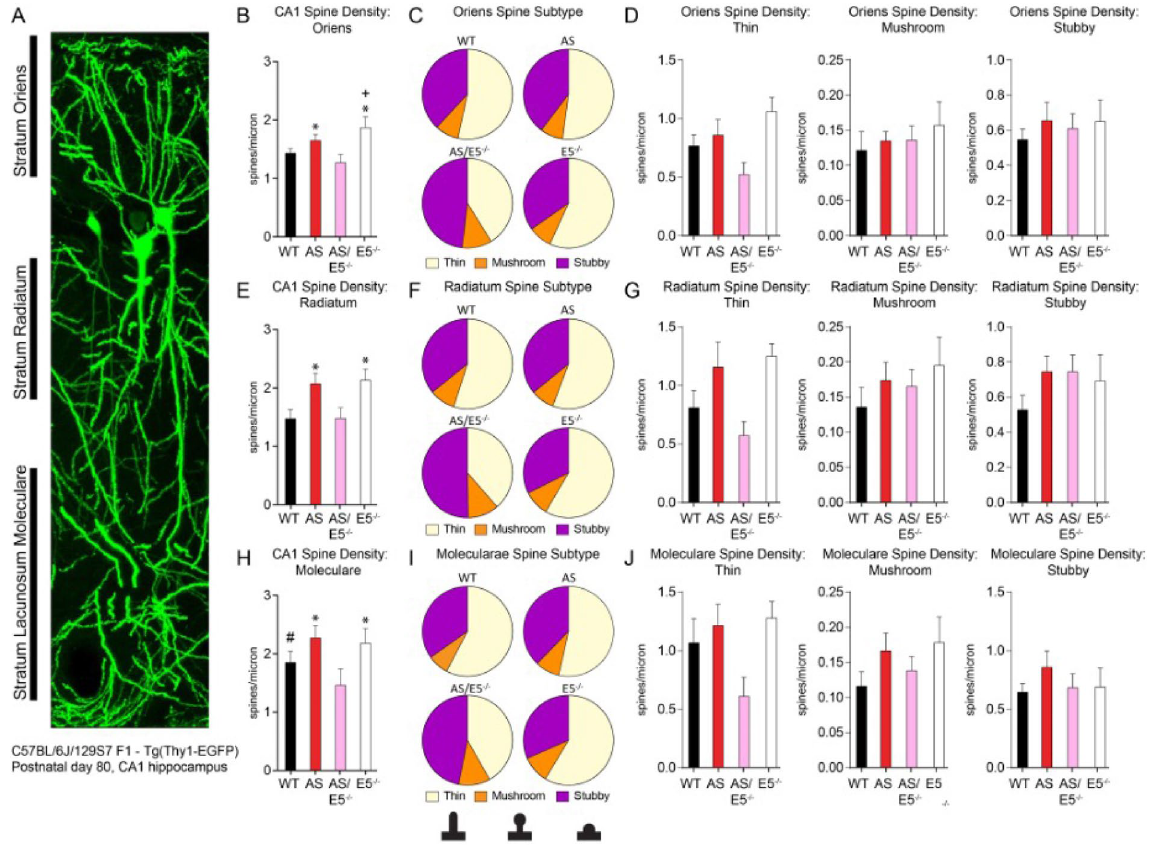
Figure 3. UBE3A expression in CA1 and location of spine analysis in CA1 GFP-positive neurons, related to Fig. 3. ( A ) Example CA1 GFP-positive neurons with the regions of interest labeled (stratum oriens, stratum radiatum, and stratum moleculare). Scale bar is 10 μm. ( B ) Oriens spine density in CA1. ( C ) Proportion of spine subtypes within WT, AS, AS/E5 −/− , and E5 −/− oriens dendrites of CA1 neurons. ( D ) Spine density in the stratum oriens of CA1 neurons for thin, mushroom, and stubby morphologies. ( E ) Radiatum spine density in CA1. ( F ) Proportion of spine subtypes within WT, AS, AS/E5 −/− , and E5 −/− radiatum dendrites of CA1 neurons. ( G ) Spine density in the stratum radiatum of CA1 neurons for thin, mushroom, and stubby morphologies. ( H ) Moleculare spine density in CA1. ( I ) Proportion of spine subtypes within WT, AS, AS/E5 −/− , and E5 −/− moleculare dendrites of CA1 neurons. ( J ) Spine density in the stratum lacunosum moleculare of CA1 neurons for thin, mushroom, and stubby morphologies. One-way ANOVA, post-hoc Tukey’s multiple comparisons test for panels B, E, and H. Two-way ANOVA, post-hoc Sidak’s multiple comparisons test for panels D, G, and J. All data are presented as mean ± SEM (n = 3 for all genotypes) * p < 0.05 compared to WT and AS/E5 −/− , + p < 0.05 compared to AS, # p < 0.05 compared to AS/E5 −/− for all panels. See also Supplementary Fig. 3. Degrees of freedom and exact p values are reported in Supplementary Table 2 and Supplementary Table 3. Image analysis was performed using Fiji/ImageJ (v2.0.0—imagej.nih.gov/ij/docs/guide/146–2.html), and NeuronStudio (research.mssm.edu/cnic/